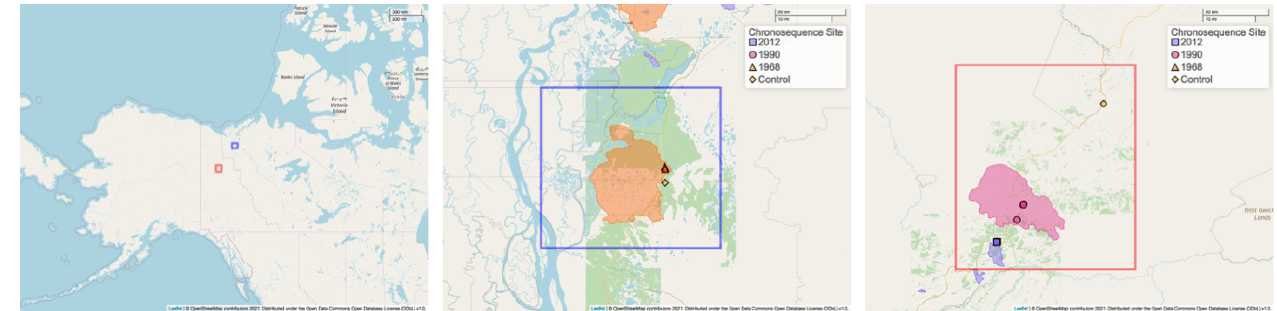
Figure 1. Map of chronosequence site locations in the Yukon and the Northwest Territories of Canada. In the two inset maps the boundaries of the fire areas are shown along with the location of the sampling sites (color-coded the same as the fire areas). Fire boundary areas are determined from geographic data from the Canadian Wildfire Information System (Natural Resources Canada, 2021). The middle inset map also shows additional fire areas burned in 1968 and 2012. Maps provided by OpenStreetMap; © OpenStreetMap contributors 2021. Distributed under the Open Data Commons Open Database License (ODbL) v1.0.